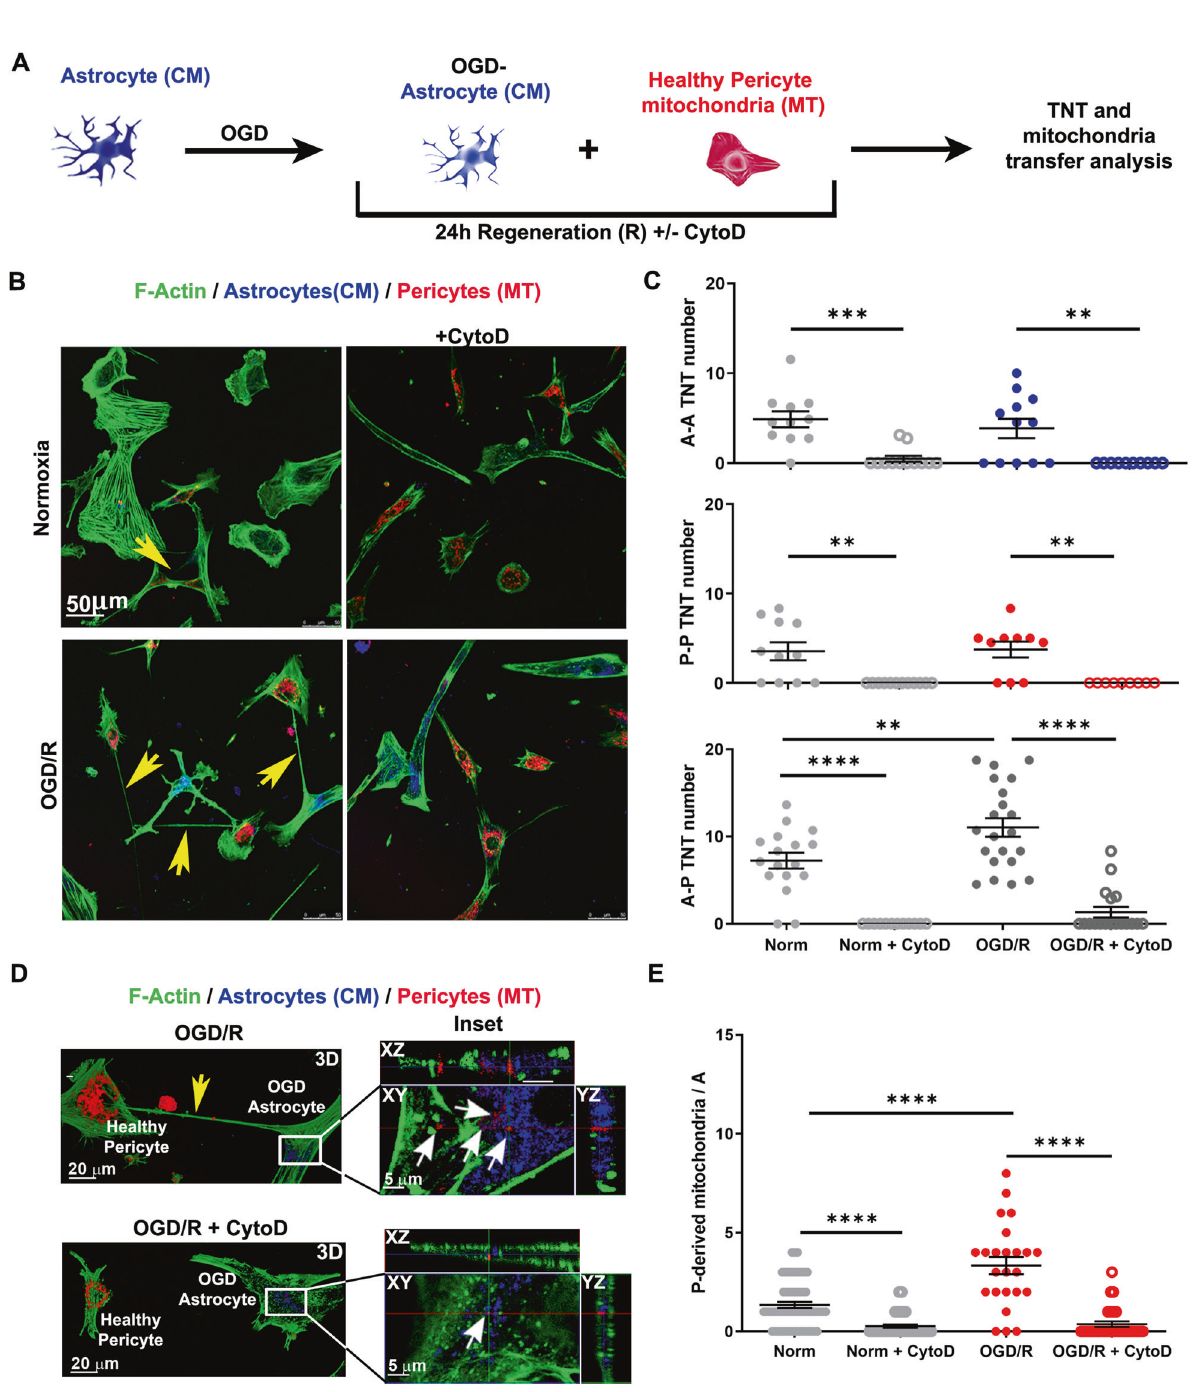
Fig. 3 Endothelial cells and pericytes transfer functional mitochondria to astrocytes in a 3D assembloids model of human BBB. A, B Functional mitochondria from either pericytes or brain endothelial cells were stained with MT (red), while astrocyte membranes were labeled with CM (blue). To generate BBB assembloids, labeled astrocytes were cultured with either labeled pericytes and unlabeled endothelial cells ( A ) or labeled endothelial cells and unlabeled pericytes ( B ). After 2 days in culture, assembloids were fi xed and analyzed by confocal microscopy for MT localization. 3D reconstructions and Z-projections acquired at low magni fi cation show either pericytes (A1, red) or endothelial cells (B1, red) localized in the assembloid shell, with astrocytes localized in the assembloid core (A1, B1, blue). In both cases, high magni fi cation analysis reveal MT-stained mitochondria (red) in the assembloid core (A2/A3; B2/B3). Representative images from N = 3 independent preparations with N ≥ 3 assembloids per experiment. C, D Immuno fl uorescence and high magni fi cation confocal analysis of the assembloid core using anti-GFAP antibodies. XY planes and Z projections of the assembloid core show MT-stained mitochondria (red) from either pericyte ( C ) or endothelial cells ( D ) inside GFAP-positive astrocytes. Representative images from N = 2 independent experiments in which N ≥ 6 assembloids per experiment were